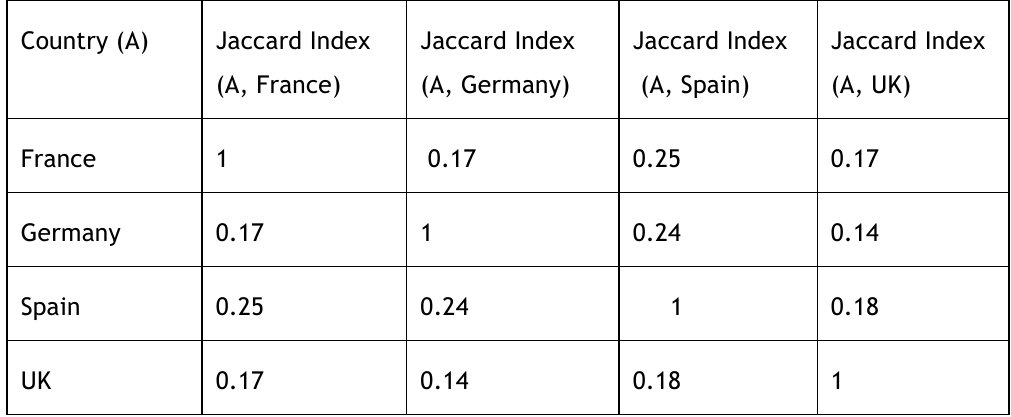
Table 2: Jaccard Indices Showing Inter-Country Agreement between Data Categories Offered by Open Data